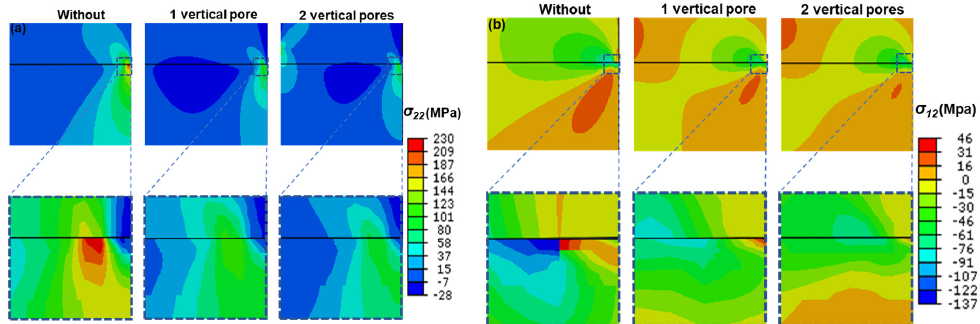
Figure 6. Variation of stress field: ( a ) σ 22 and ( b ) σ 12 at crack tip for 3 mm thickness of TC without, with one vertical pore, and with two vertical pores. The depth of vertical pores was 2.5 mm.